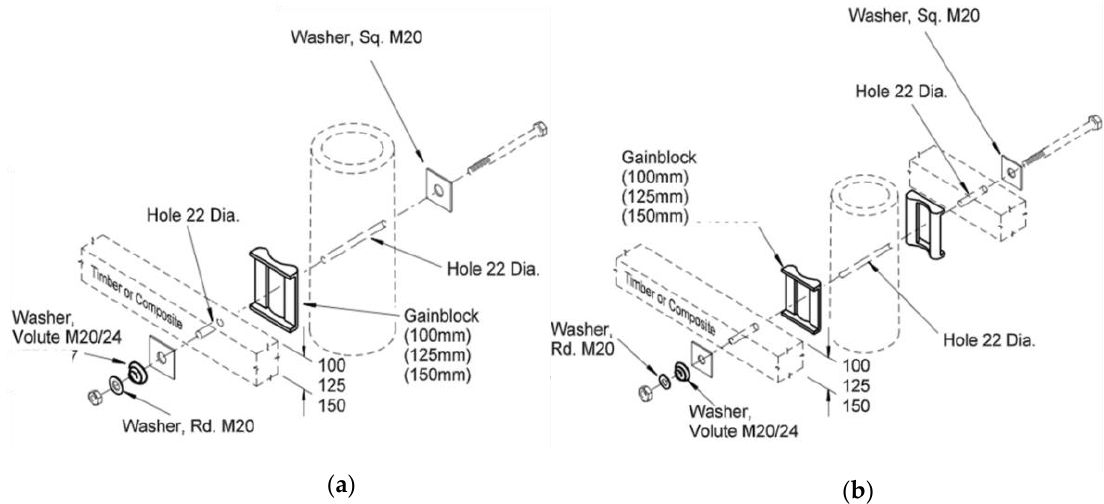
Figure 4. Predrilled crossarm assembly: ( a ) single crossarm; ( b ) double crossarm [31].